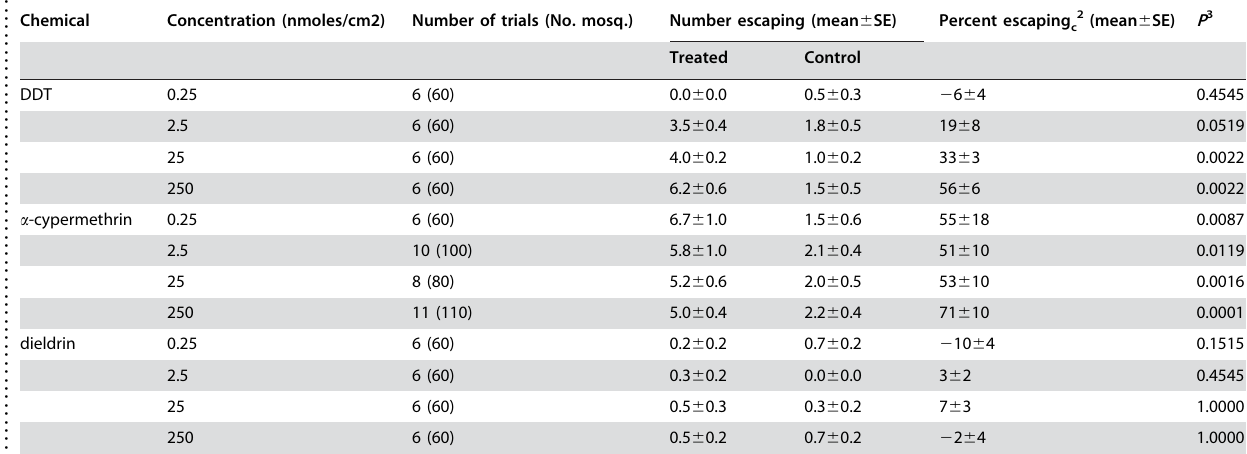
Table 1. Response of female Aedes aegypti 1 in the contact irritancy assay to selected chemicals in the laboratory. .. ... .... ... ... .... ... ... .... ... ... .... ... ... .... ... ... .... ... ... .... ... ... .... ... ... .... ... ... .... ... ... .... ... ... .... ... ... .... ... ... .... ... ... . Chemical Concentration (nmoles/cm2) Number of trials (No.